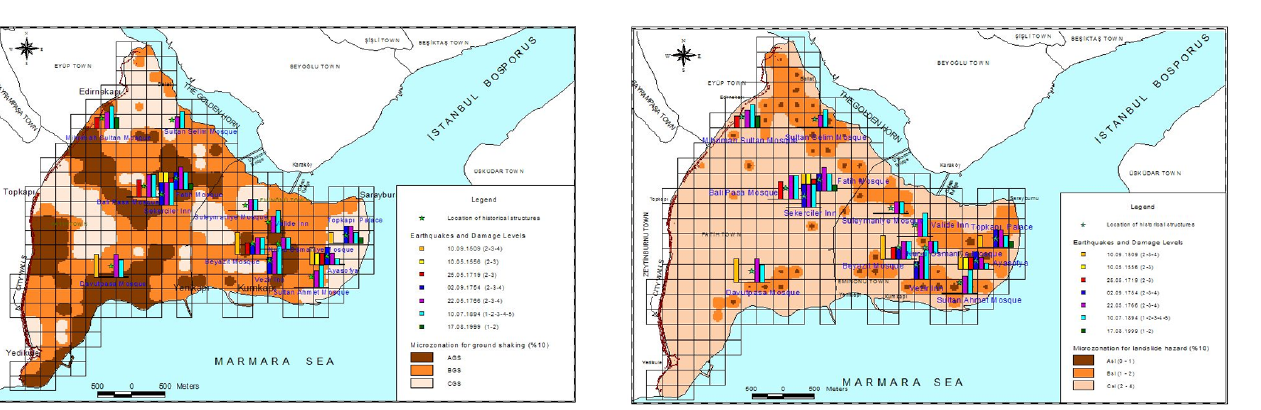
Figure 17. Comparison of damage levels in various earthquakes and the liquefaction hazard